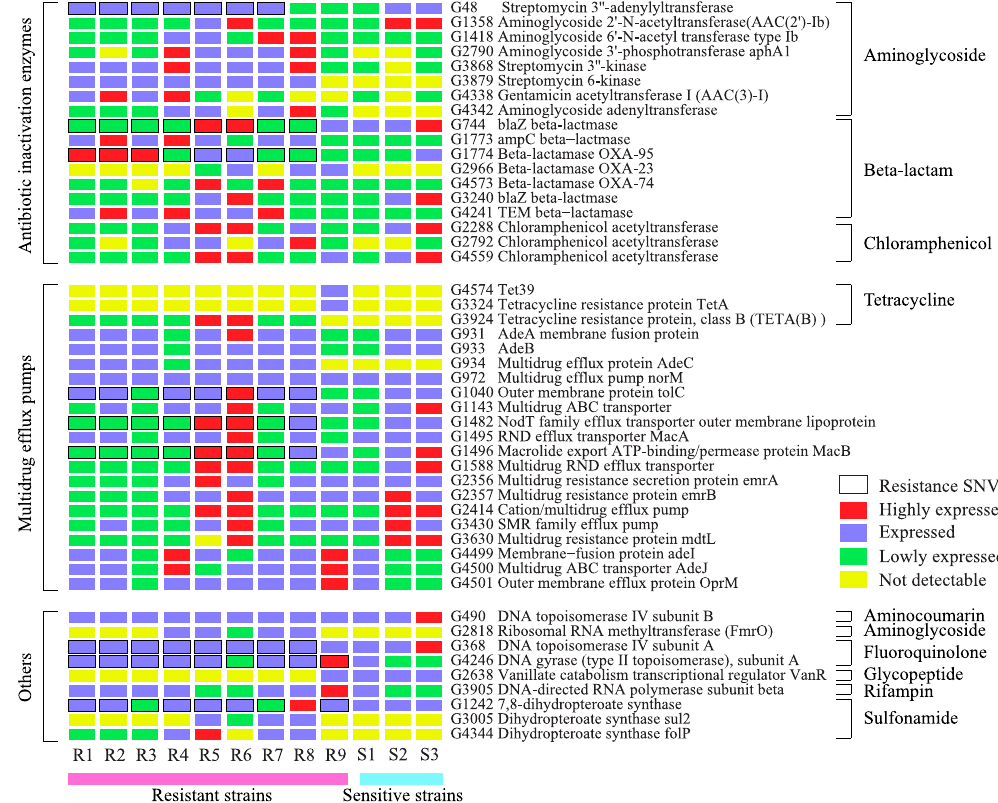
Figure 3. Antibiotic resistance genes were widely distributed in resistant and sensitive strains. Each square represents the expression level of a gene (across the row) in a given strain (down the column). Genes are grouped according to protein functions, followed by the type of antibiotic resistance that the gene is associated